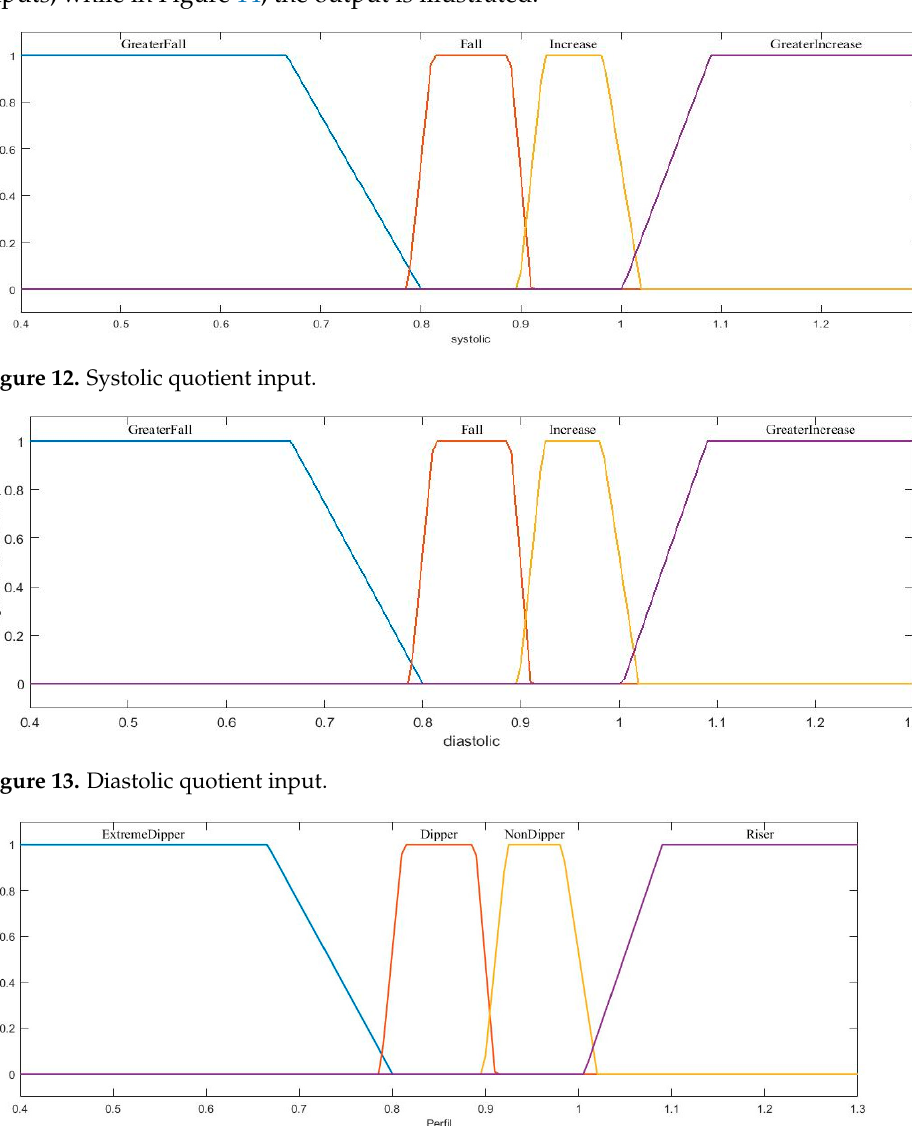
Figure 11. DBSA applied in the optimization of fuzzy system.